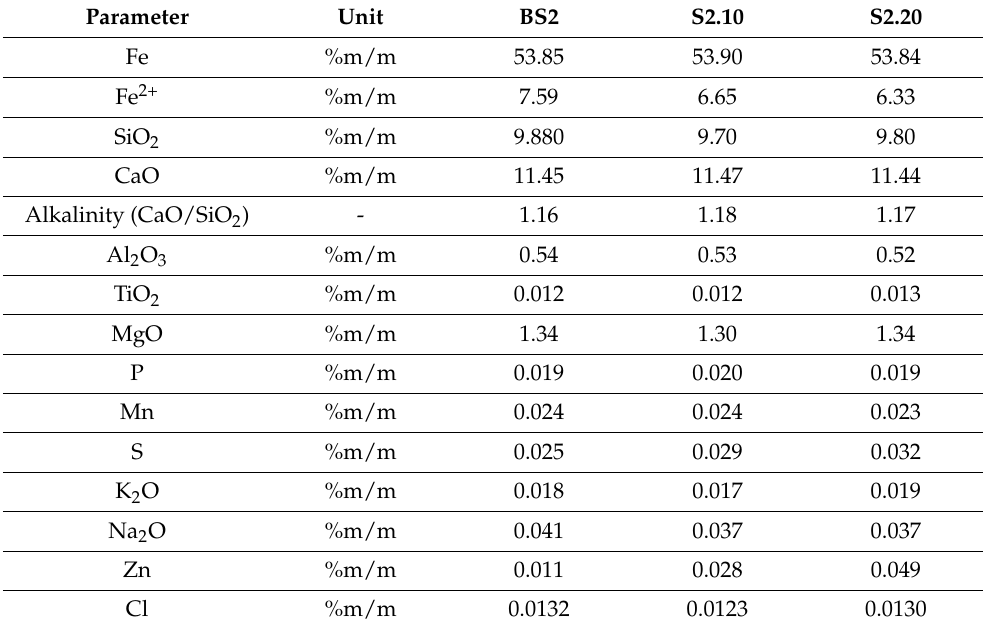
Table 8. Average results of chemical analysis for sinter with TC2 in comparison to BS2 basic